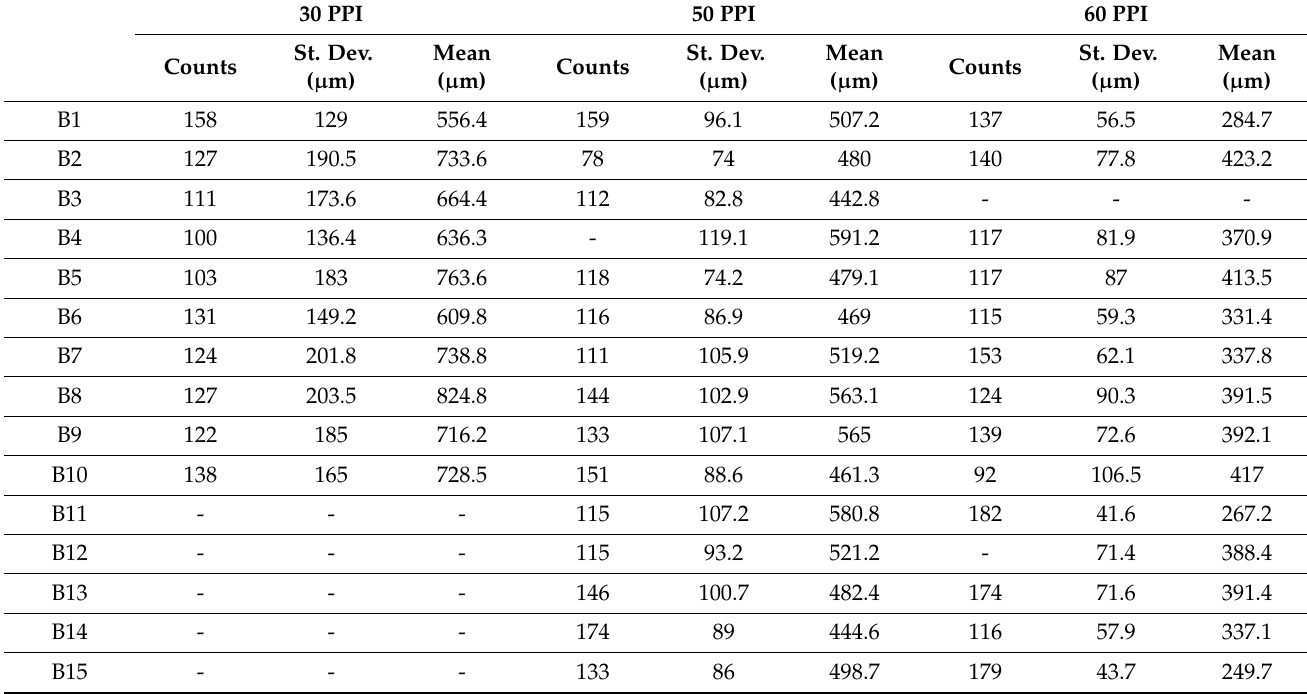
Table A7. Mean Window’s Feret diameter ( d w ) of CFF samples of 30 PPI, 50 PPI and 60 PPI from supplier